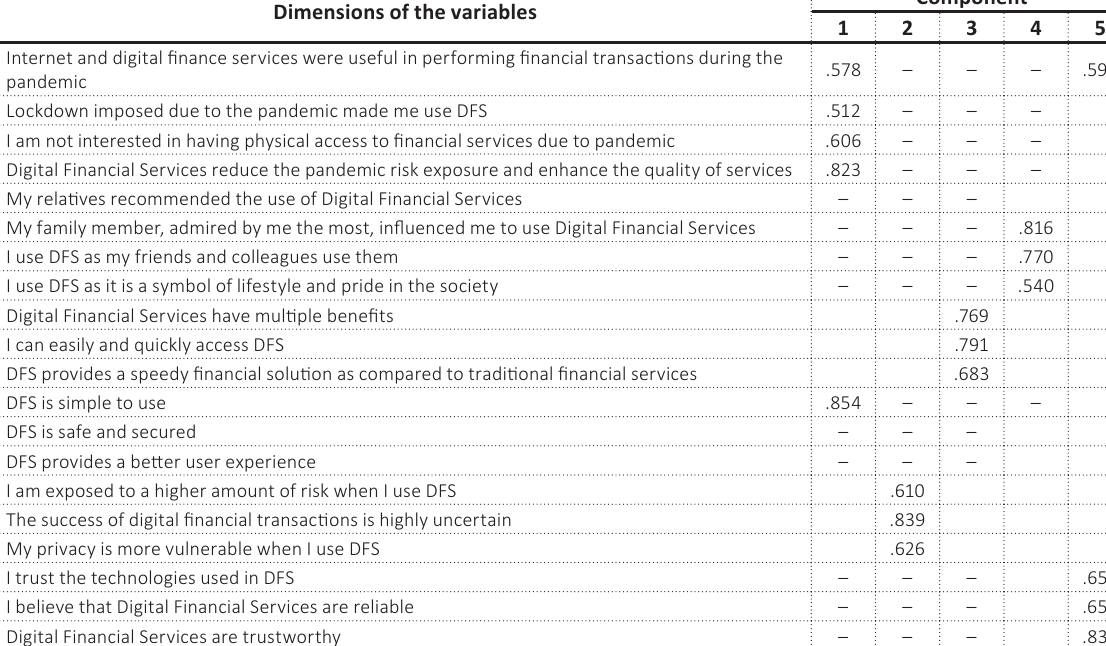
Based on loadings of the factors, five factors found in factor analysis are named Pandemic forces and convenience, perceived safety, user benefits and Table 10. Rotated component (factor) matrix Dimensions of the variables